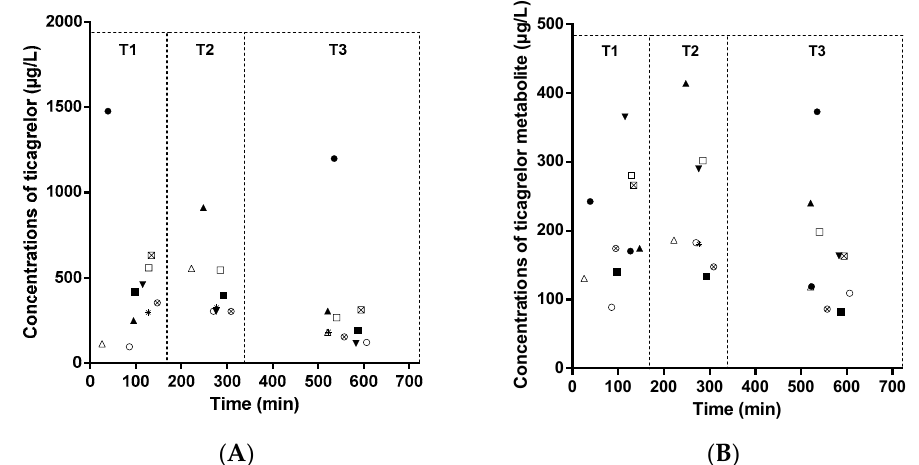
Figure 2. Plasma concentrations versus time: ( A ) ticagrelor ( B ) metabolite AR-C124910XX for n = 28 blood sampling in 10 patients after multiple oral administrations of 90 mg bid ticagrelor; with T1: between 0 and 180 min, T2: between 180 and 360 min, T3: between 360 and 720 min. The same symbol is used for the same patient in both charts.